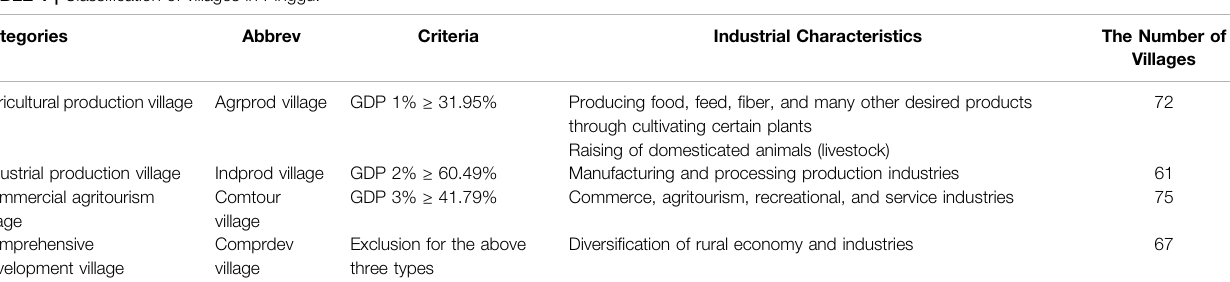
TABLE 1 | Classi fi cation of villages in